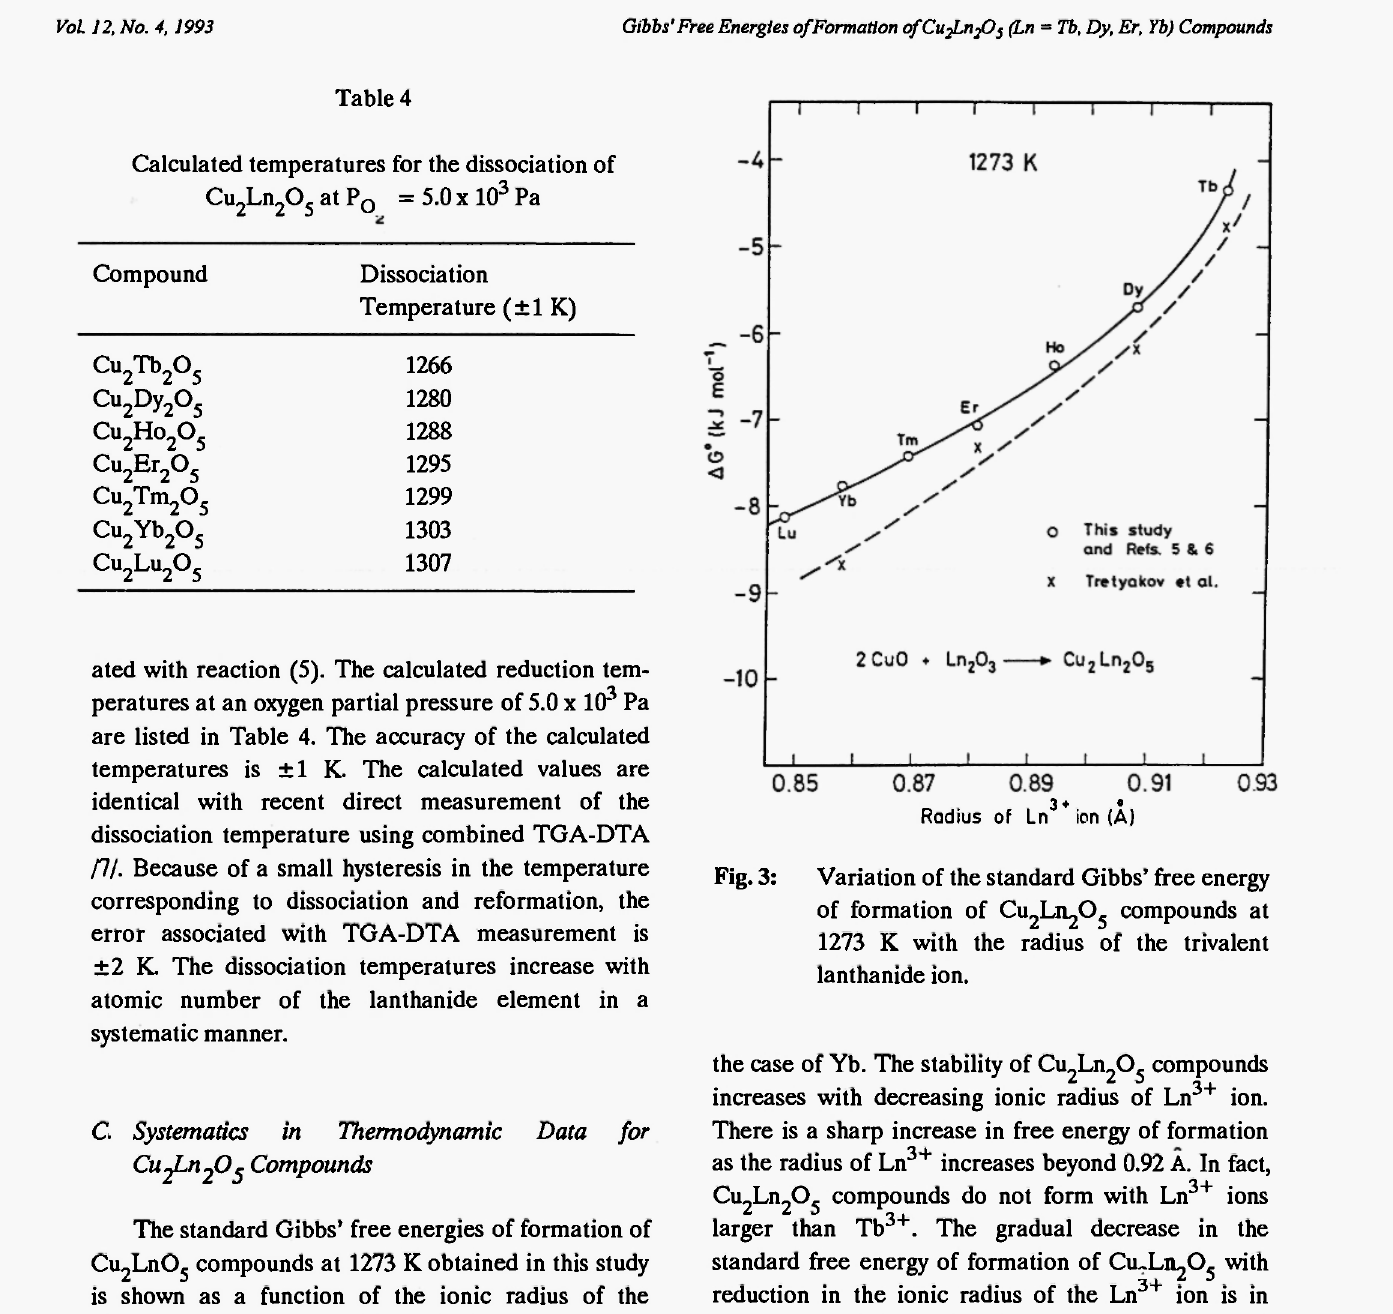
Fig. 3: Variation of the standard Gibbs' free energy of formation of C^LI^OJ compounds at 1273 Κ with the radius of the trivalent lanthanide